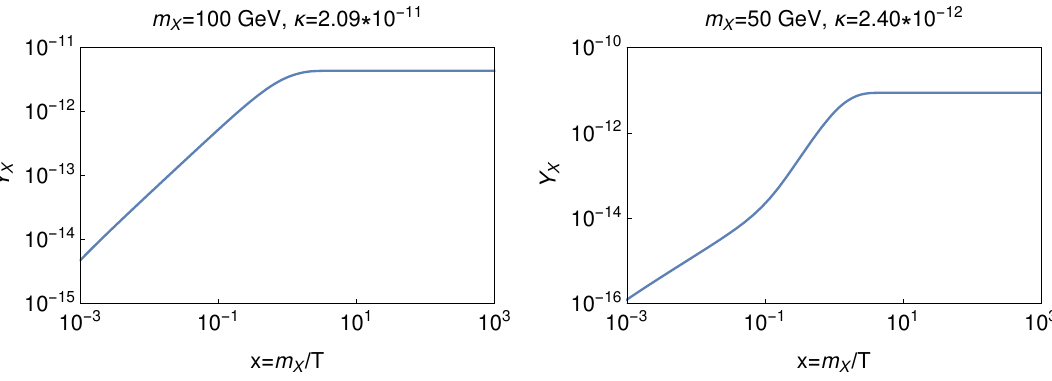
Figure 2 . Examples of evolutions of the VDM yield Y X as the functions of x = m X =T , in which the model parameters for both panels are chosen the same as those in (cid:12)gure 1.